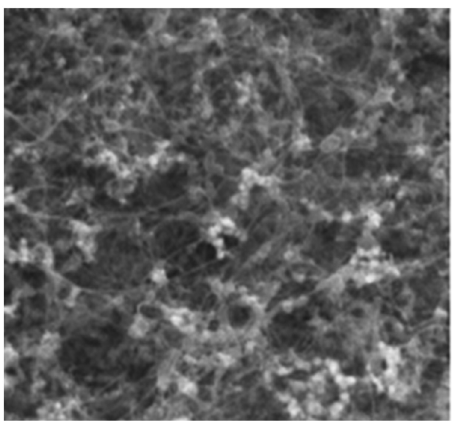
Figure 1: Appearance of carbon nanotubes.